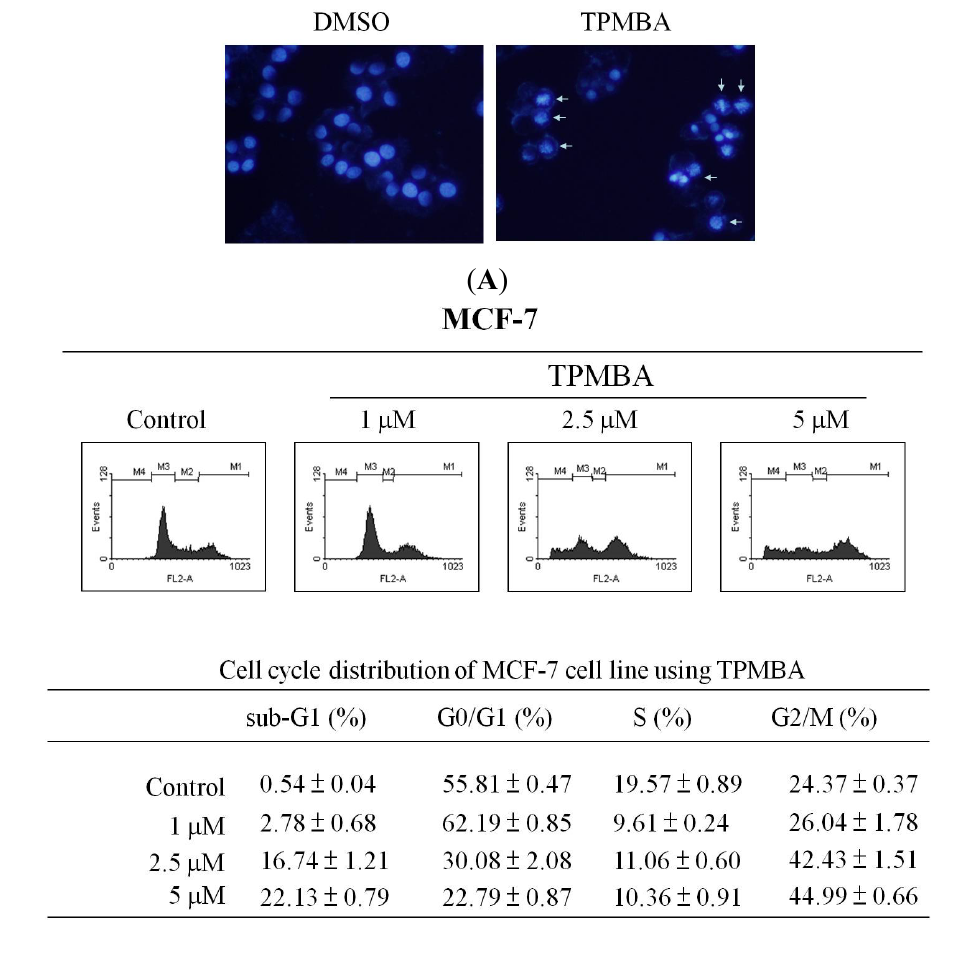
Figure 4. TMPBA induced G2/M arrest and apoptosis in MCF-7 cells. ( A ) MCF-7 cells were treated with 5 µM TMPBA for 12 h, the morphological changes were being analyzed by fluorescence microscopy with DAPI staining. Cells had nuclei maintaining mesh-like structure of chromatin or condensed chromatin (arrow); ( B ) Flow cytometric analysis of cell cycle in MCF-7 cells with TMPBA in 10% FBS-containing DMEM for 12 h. MCF-7 cells were cultured with TMPBA for the dose indicated. The cells were analyzed by flow cytometry after staining with propidium iodide (PI); ( C ) The percentages in the graphs represent the percent of cell cycle phases in the respective quadrants (M1:G2/M phase; M2: S phase; M3: G1 phase; M4: Sub-G1 phase). Columns, mean; bars, SD; ( D ) Flow cytometric analysis of dose-dependent effect of TMPBA on caspase-3 activity in MCF-7 cells. The relative caspase-3 activities, normalized to DMSO control, at the indicated concentrations of the compound. Columns , mean of three independent experiments; bars, SD ( n = 3). Significant differences ( * p < 0.05, *** p < 0.001) between the control and experimental group are marked with